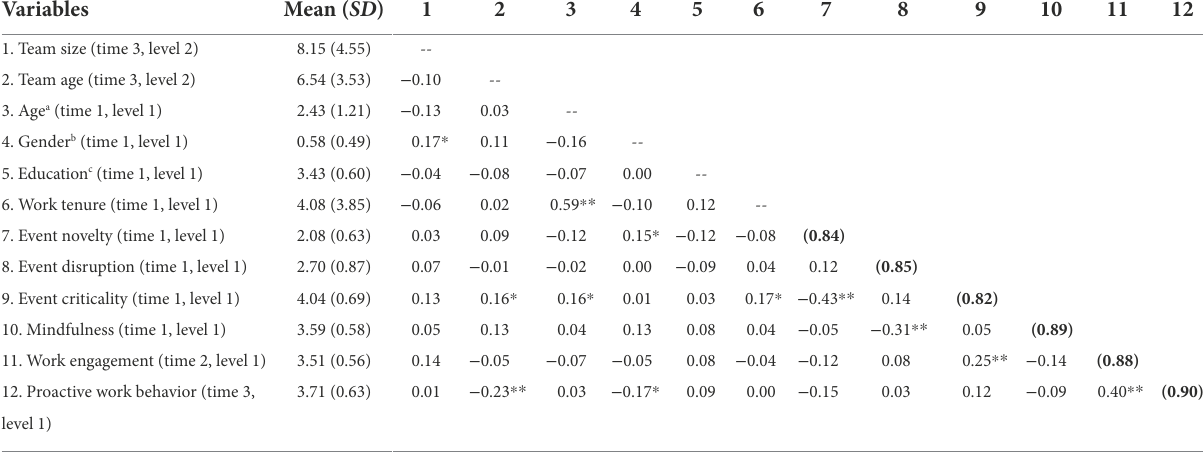
TABLE 2 Means, standard deviations, and correlations.